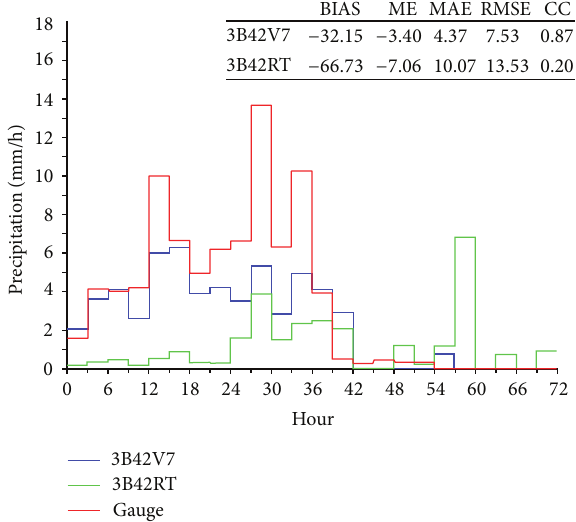
Figure 4: Precipitation time series over Swat Basin during 28–30 July 2010 storm event.